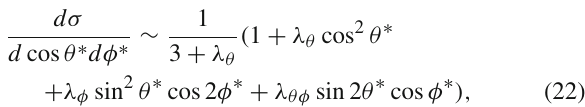
χ b ( 3 P ) Fig. 5 The ratio R ϒ( 3 S ) calculated as function of of all histograms is the same as in Fig. 3. The experimental data are from LHCb